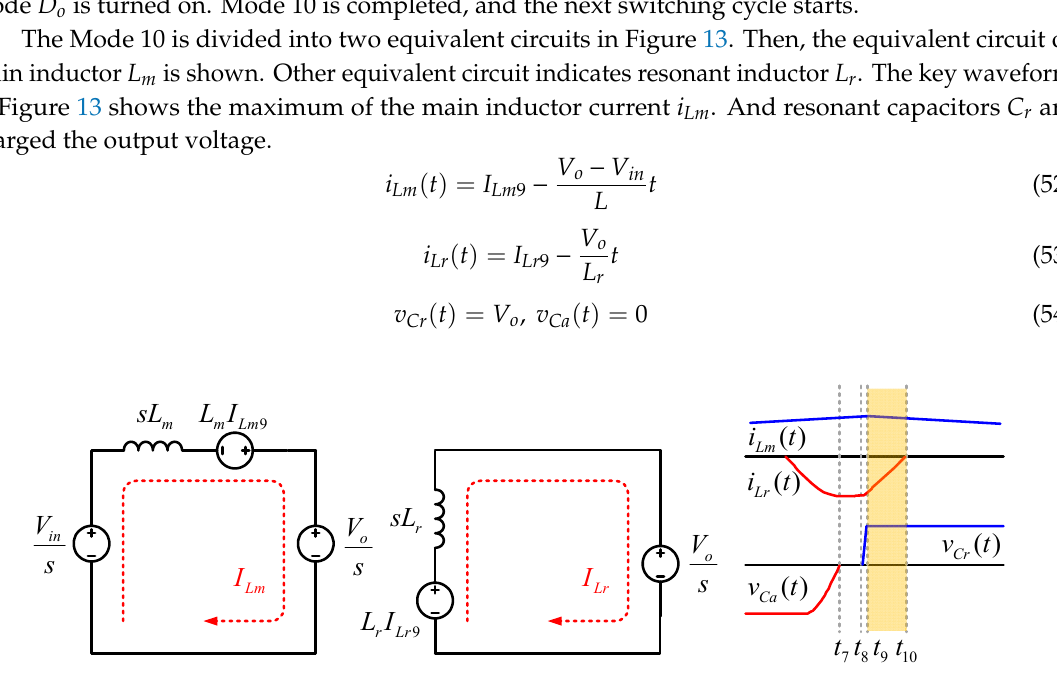
Figure 13. The equivalent circuit of Mode 10 and key waveform.